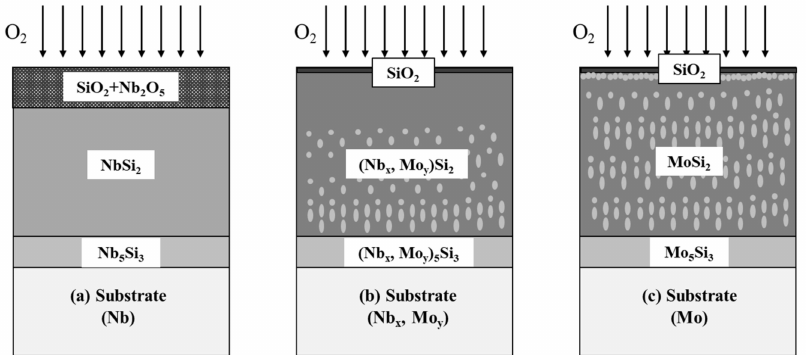
Figure 10. Schematic diagram of oxidation behavior of Si-pack-coated ( a ) Alloy 1 (Nb), Alloy 2 (Nb 73.6 Mo 26.4 ) and Alloy 3 (Nb 51.2 Mo 48.8 ), ( b ) Alloy 4 (Nb 35.1 Mo 64.9 ) and Alloy 5 (Nb 25.7 Mo 74.3 ), and ( c ) Alloy 6 (Mo) after oxidation tests at 1200 ◦